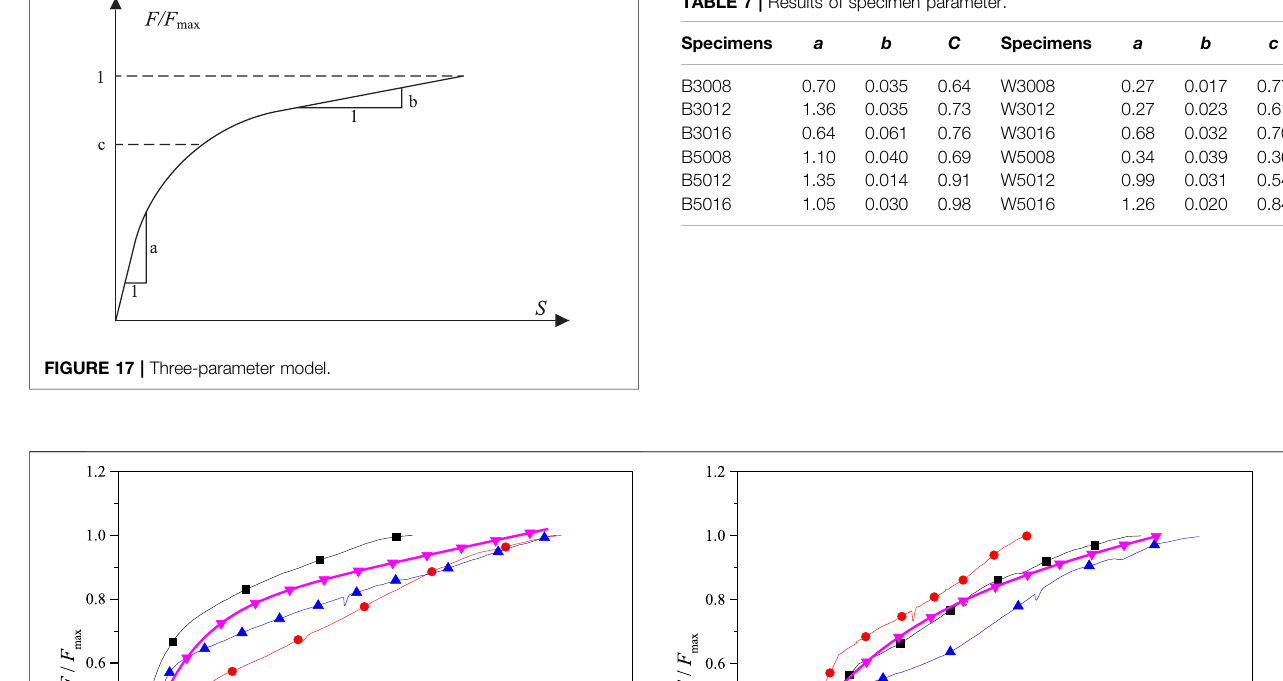
Frontiers in Materials |